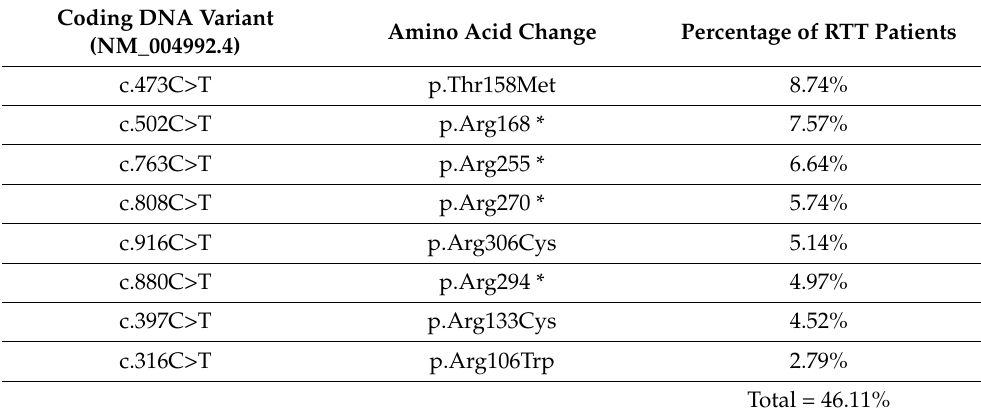
Table 1. Most recurrent point mutations in MECP2 and their frequencies in RTT patients